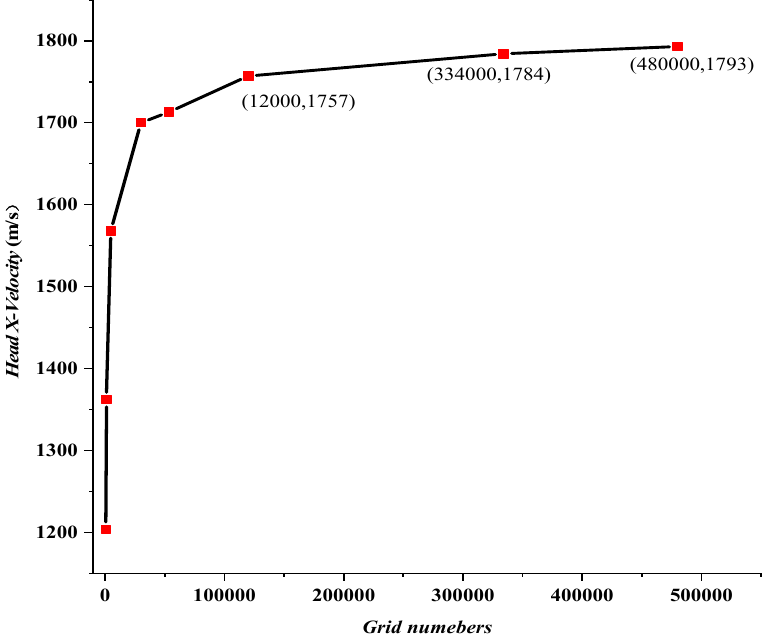
Figure 6. Head X-velocity of a projectile with different grid numbers.